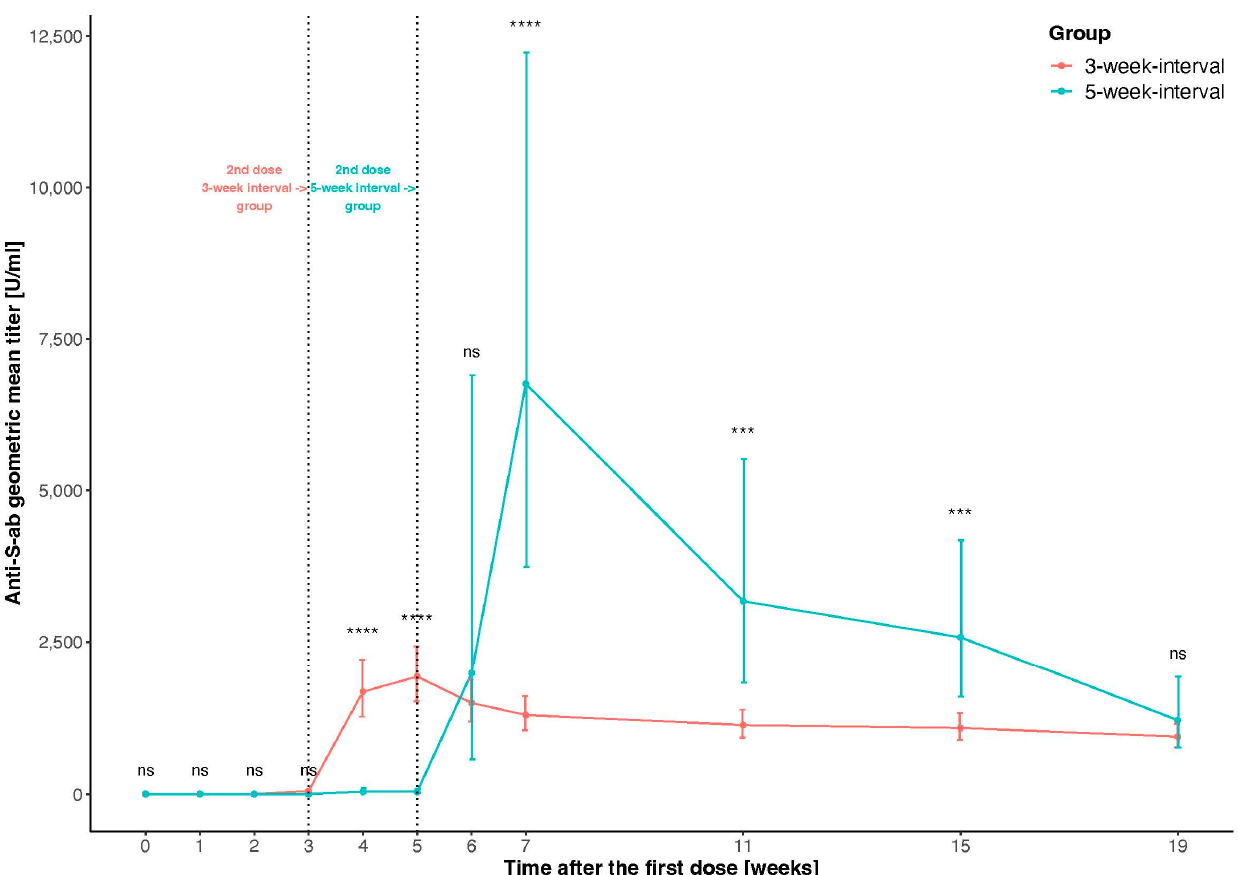
Figure 1. Response in anti-s-ab concentrations to COVID-19 vaccine in 19-week observation. Pre- sented are the standardized geometric means and the 95% confidence intervals of anti-S-ab concen- trations. Significance levels: ns p >= 0.05; *** p < 0.001; **** p < 0.0001.